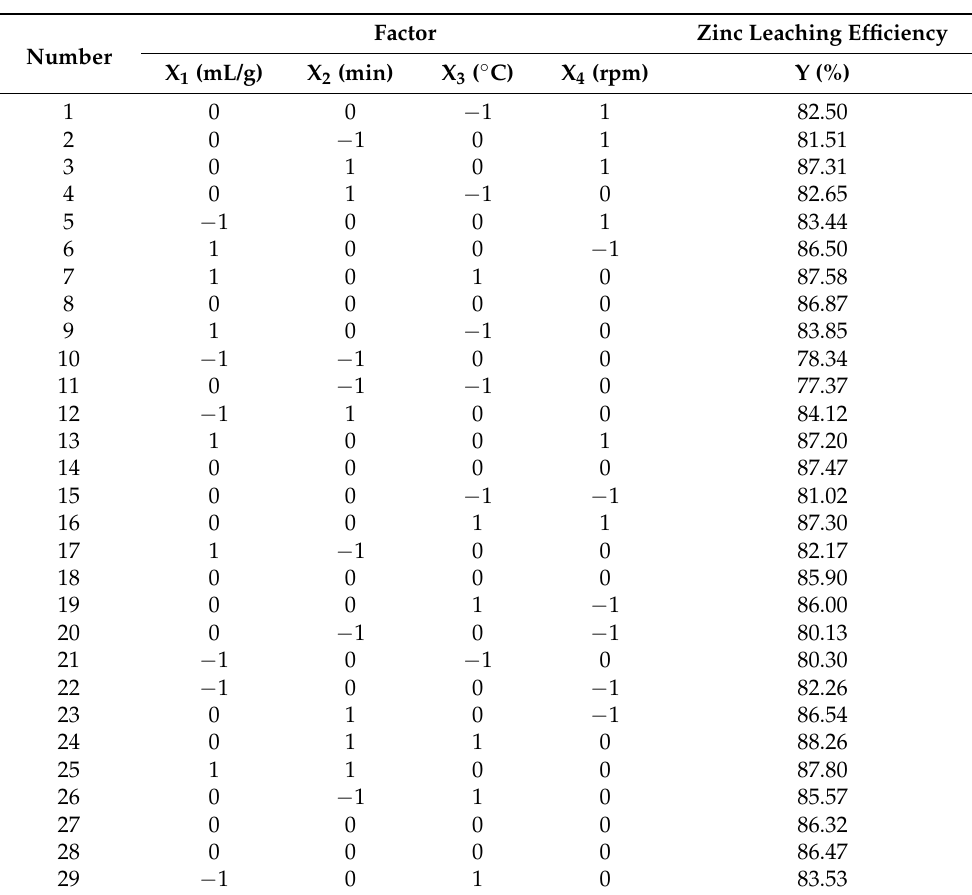
Table 3. Experimental design and